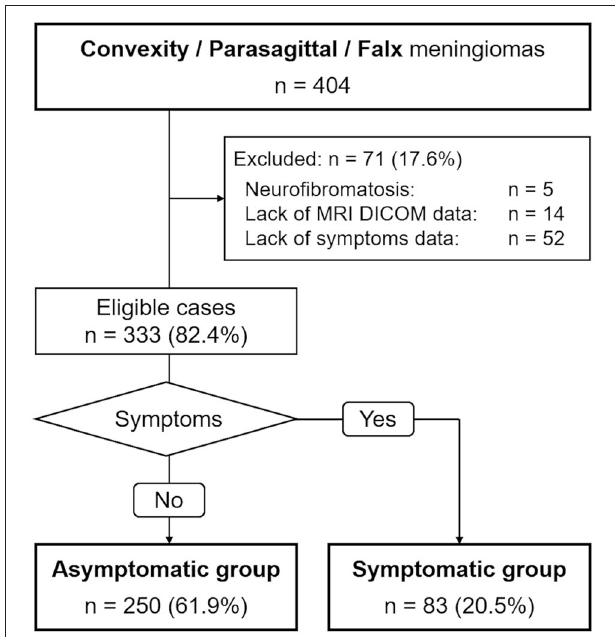
FIGURE 1 | Flow of patient selection and